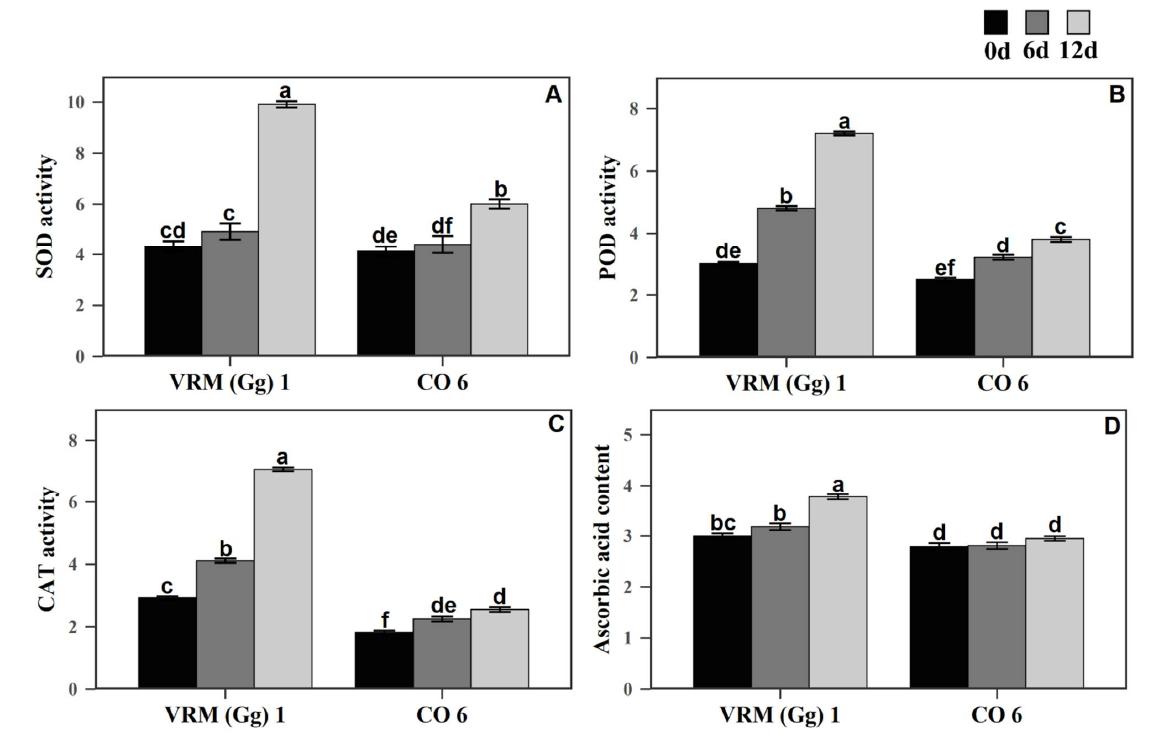
Figure 3. Activities of enzymatic and non-enzymatic antioxidants in two mungbean cultivars VRM (Gg) 1 and CO6. ( A ) SOD (Umg −1 Protein), ( B ) POD (Umg −1 Protein), ( C ) CAT (Umg −1 Protein), and ( D ) ascorbic acid (µmolg −1 FW). Values followed by the same letter are not significantly different ( p ≤ 0.05) according to duncan’s multiple range test. Bars present means ± SE ( n = 3).